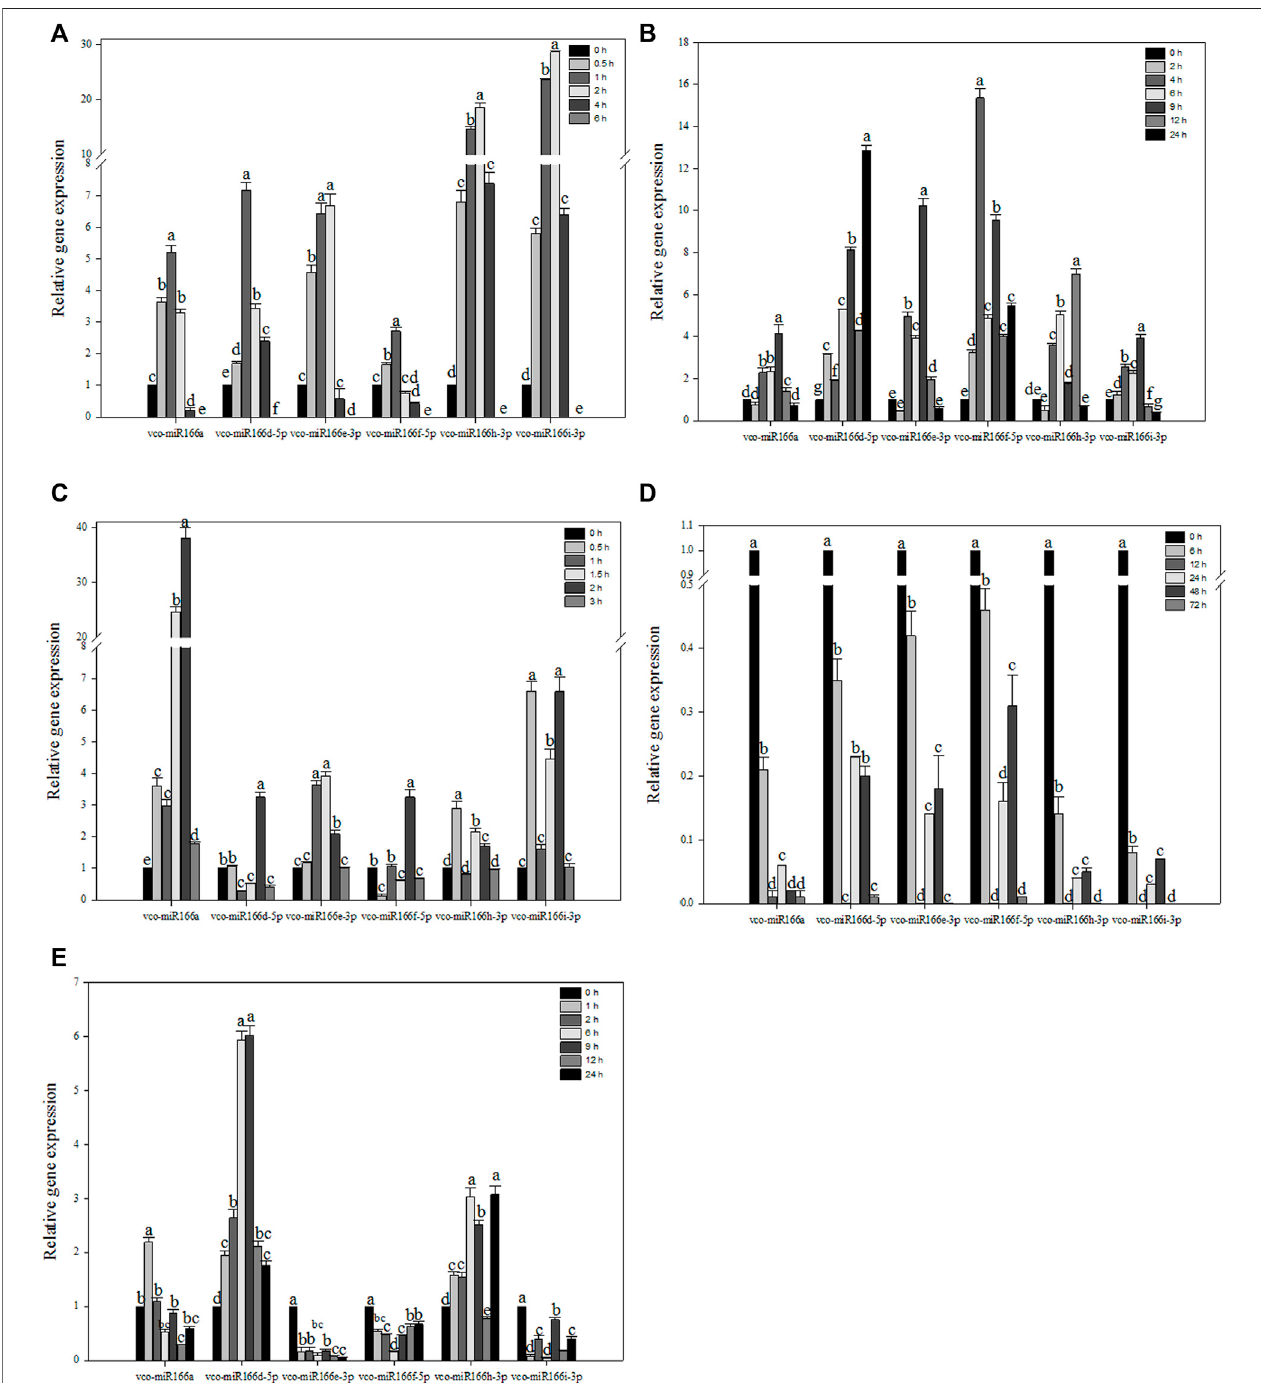
FIGURE3| RT-qPCRanalysisofVco-miR166 abundanceunder various stressconditions. Highbushblueberryplantswereexposedtofreezing (A) ,cold (B) ,heat (C) , drought (D) , and salt (E) stress. Data represent the means ± standard deviation (SD) of three independent biological replicates, each with three technical replicates. Different letters indicate signi fi cant differences ( p < 0.05) between samples, as determined by Tukey ’ s test.